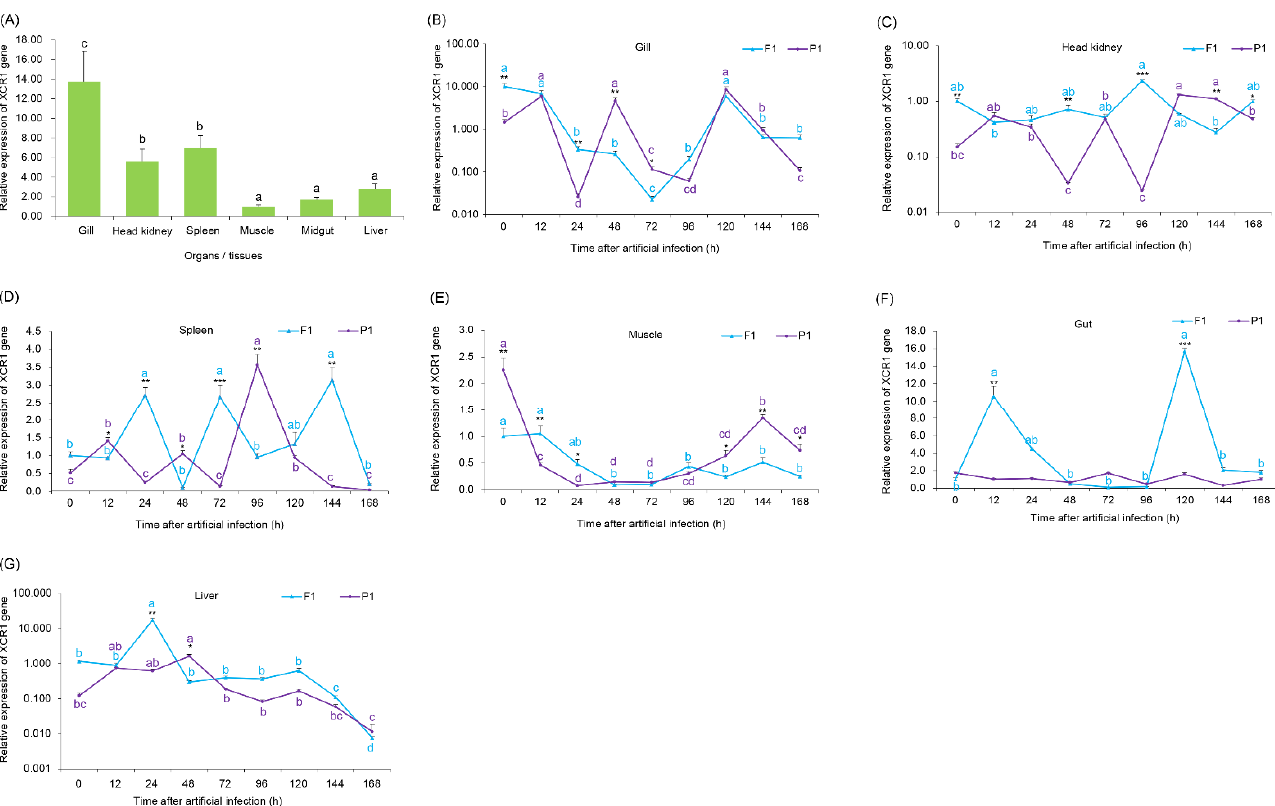
Figure 3. Relative expression of XCR1 gene in different organs or tissues of grass carp. ( A ) The relative expression of the XCR1 gene in tissues or organs of grass carp, the different letters above the bars indicate that there were significant differences between the data; ( B – F , G ) The relative expression of the XCR1 gene in the indicated sites of grass carp at different times after artificial infection of GCRV. P1, male parent grass carp with GCRV resistance; F1, the first-generation offspring of P1. Asterisks indicate significant differences in XCR1 gene expression between P1 and F1. *, p < 0.05; **, p < 0.01. The different letters indicate that there were significant differences between different times after artificial infection of GCRV. * p < 0.05; ** p < 0.01; *** p < 0.001.